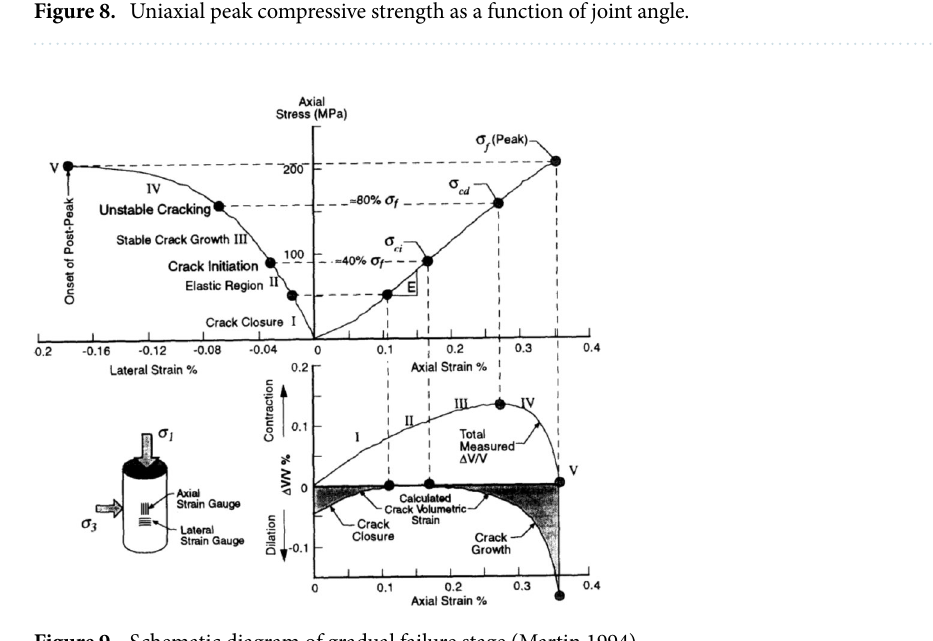
Figure 9. Schematic diagram of gradual failure stage (Martin